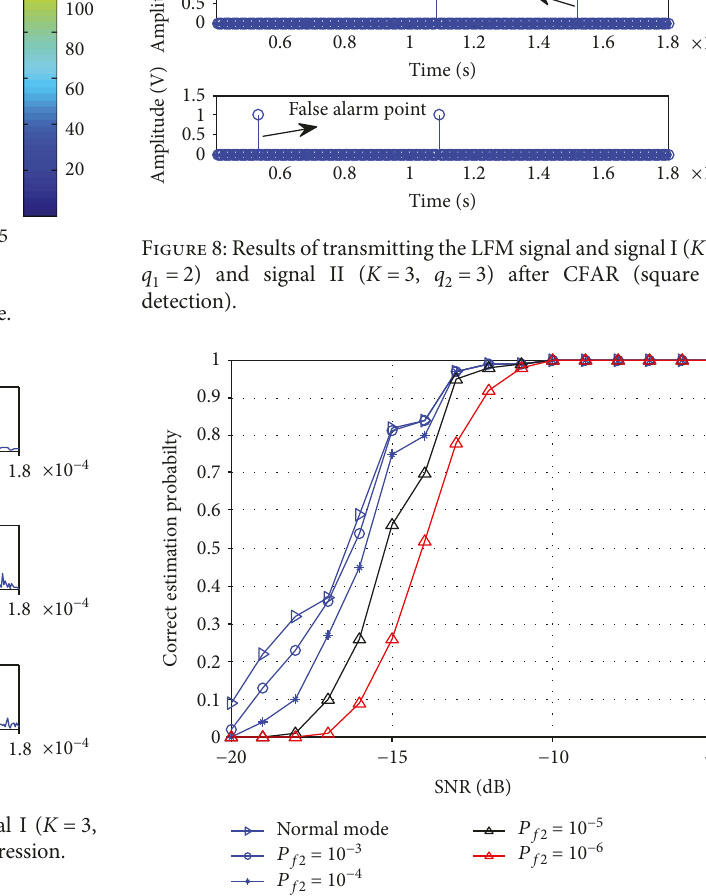
Figure 9: Probability of correct con fi rmation for target